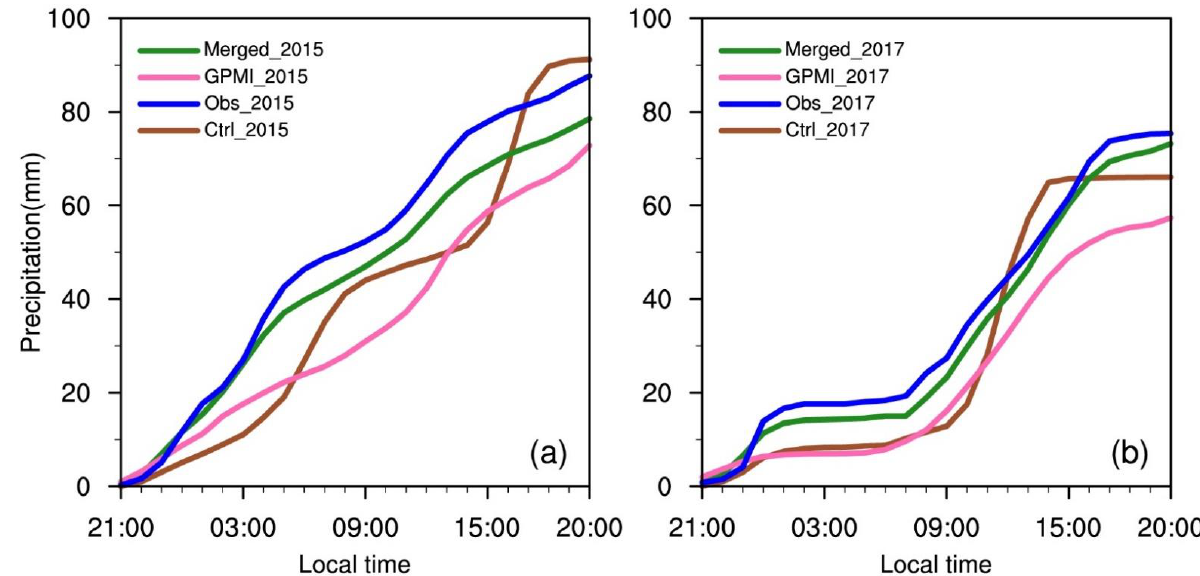
Figure 4. A comparison of the observation, GPMI, Merged, and simulated hourly accumulated pre- cipitation averaged over the study area for ( a ) EP627 and ( b ) EP925. From the composite reflectivity detected by the radar, it is known that the shear line is located near Changzhou at 15:01 and starts to intrude into the study area, then arrives in Wuxi at 16:01, and finally moves to Suzhou at 17:00 (Figure 5a1–a3). The control run simulation generally follows the radar-detected the position of the shear line, but with a slightly higher intensity than the observation (Figure